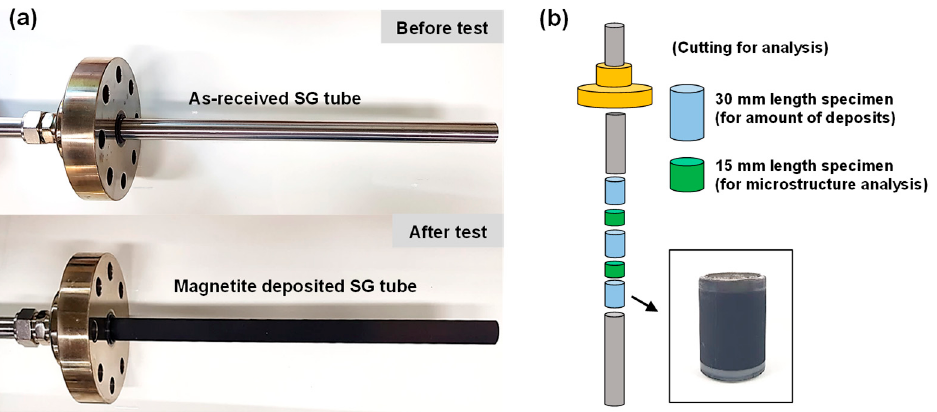
Figure 2. Images of as ‐ received and magnetite ‐ deposited SG tube specimens ( a ) and schematic of the specimen cutting ( b ).